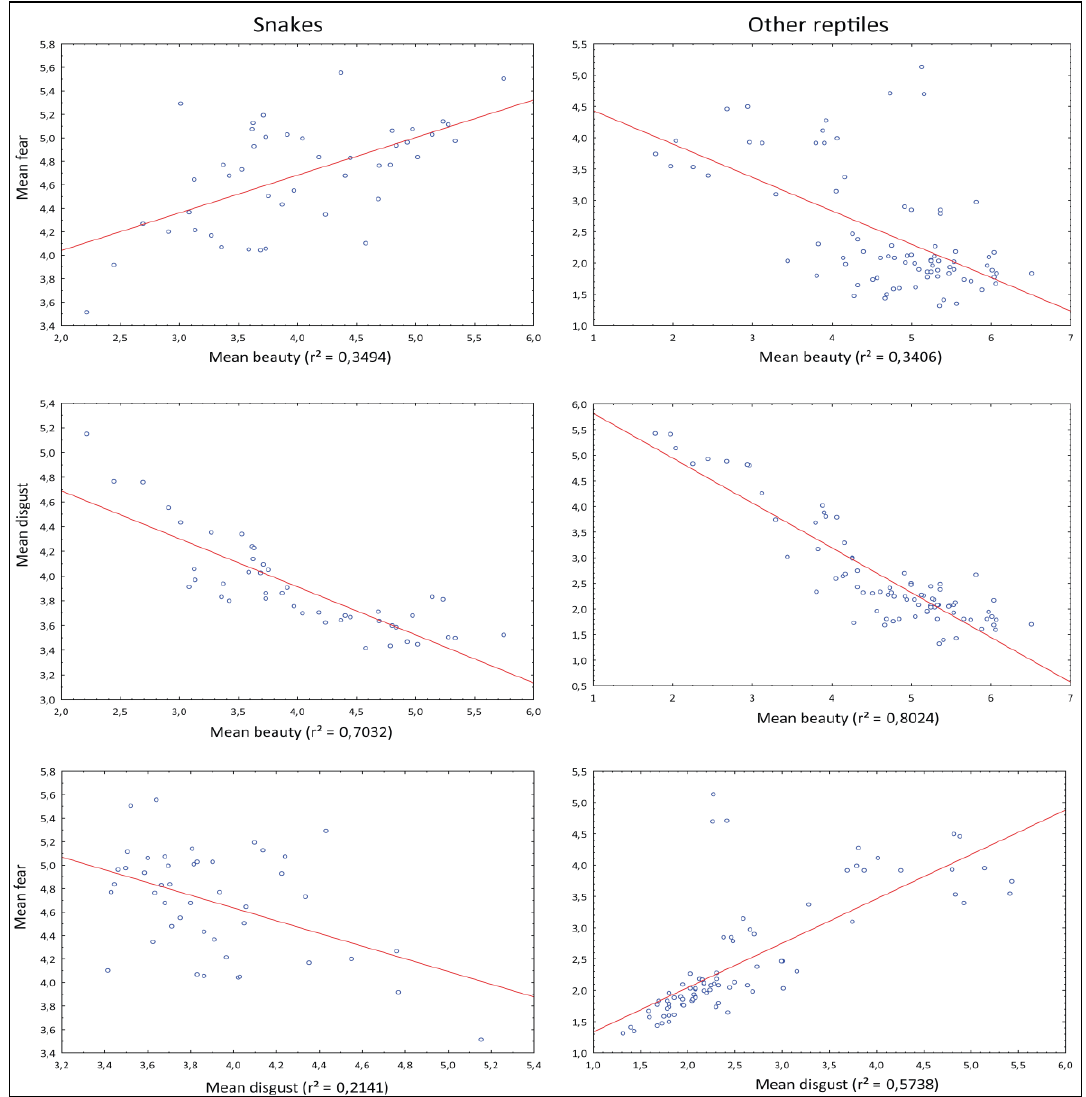
Figure 4. The correlations of the mean ranks for fear and beauty, disgust and beauty, fear and disgust; separately for snakes and other lizards.